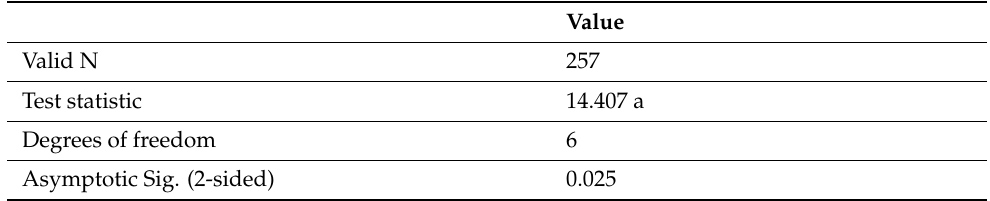
Table 6. Association between professional categories and moral distress ( p < 0.05).